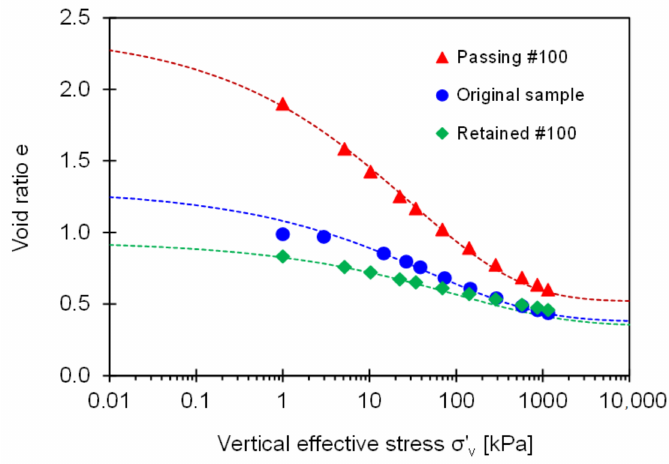
Figure 9. Compaction curves for three tested specimens in view of void ratio e against vertical effective stress σ (cid:48) v